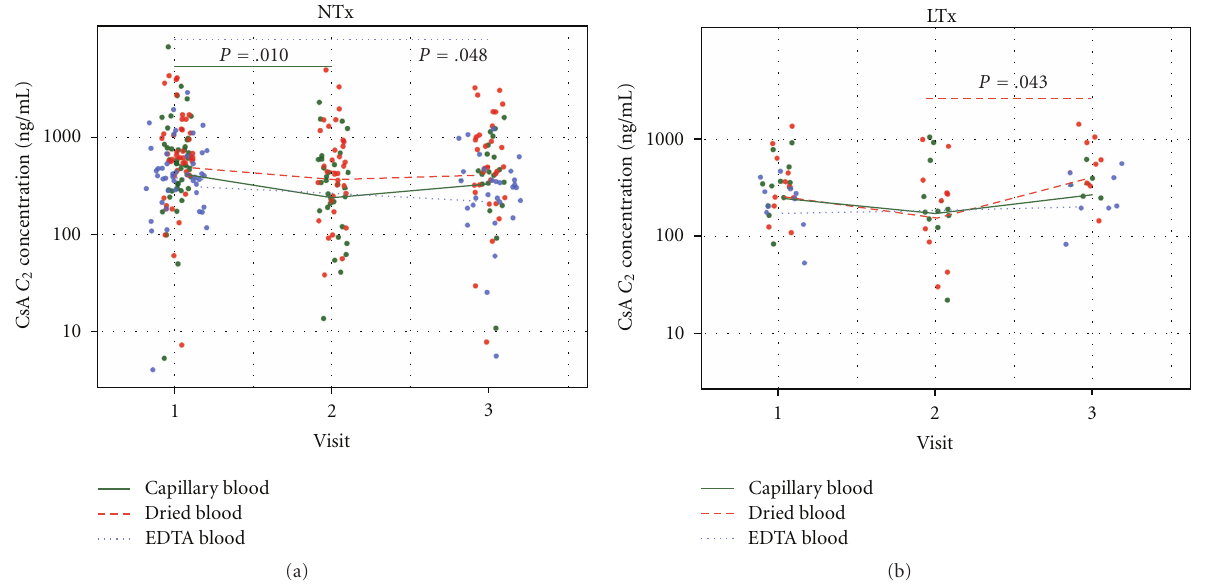
Figure 2: Absolute CsA C 2 concentrations at all visits. Dotplots of absolute CsA C 2 concentrations at all visits for renal ((a), including renal/pancreas) and liver (b) transplant recipients. Significant di ff erences are highlighted in the respective colour (capillary blood = green, dried blood = red, EDTA blood = blue). Lines represent medians.